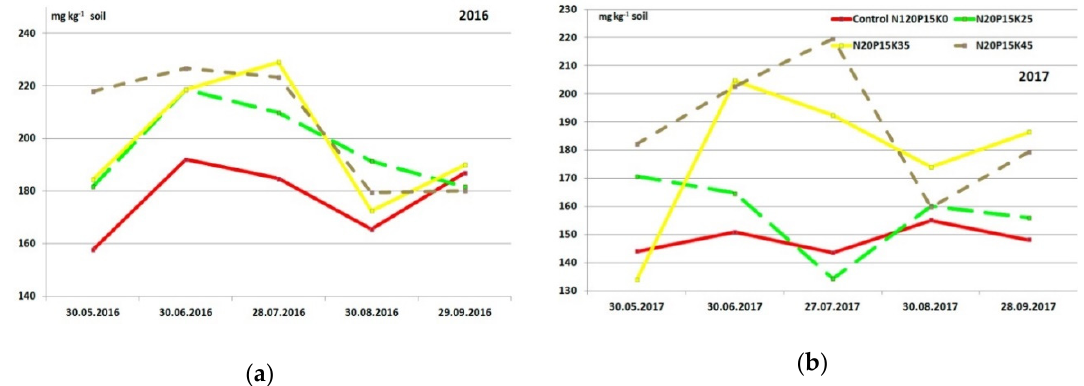
Figure 1. Seasonal changes of the soil exchangeable potassium content, cv. “Zhigulevskoye” plots: ( a ) 2016 and ( b ) 2017 (only G1 unchangeable K rates).